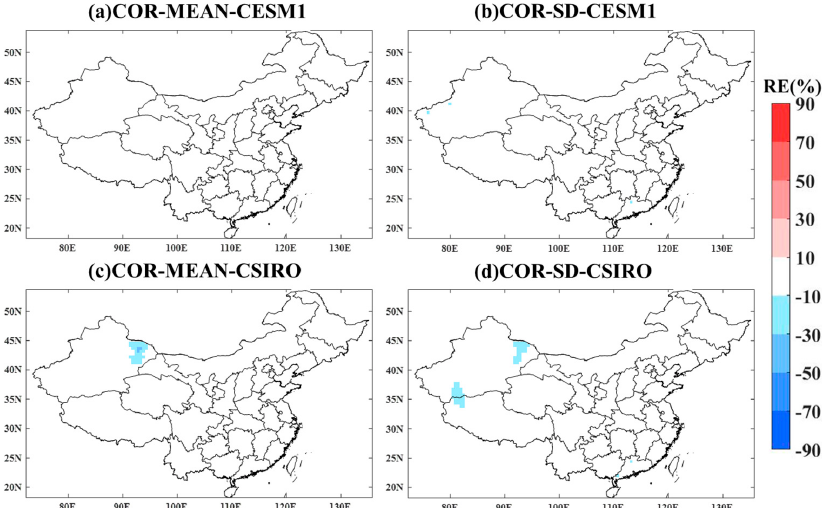
Figure 5. The relative error (RE) of the mean (MEAN) and standard deviation (SD) for July precipitation for two climate model ensembles (CESM1; CSIRO) with (COR) bias correction for the reference period (1971–2000). ( a ) The RE of the mean July precipitation for CESM1 with corrected data; ( b ) The RE of the SD of July precipitation for CESM1 with corrected data; ( c ) The RE of the mean July precipitation for CSIRO with corrected data; ( d ) The RE of the SD of July precipitation for CSIRO with corrected data.